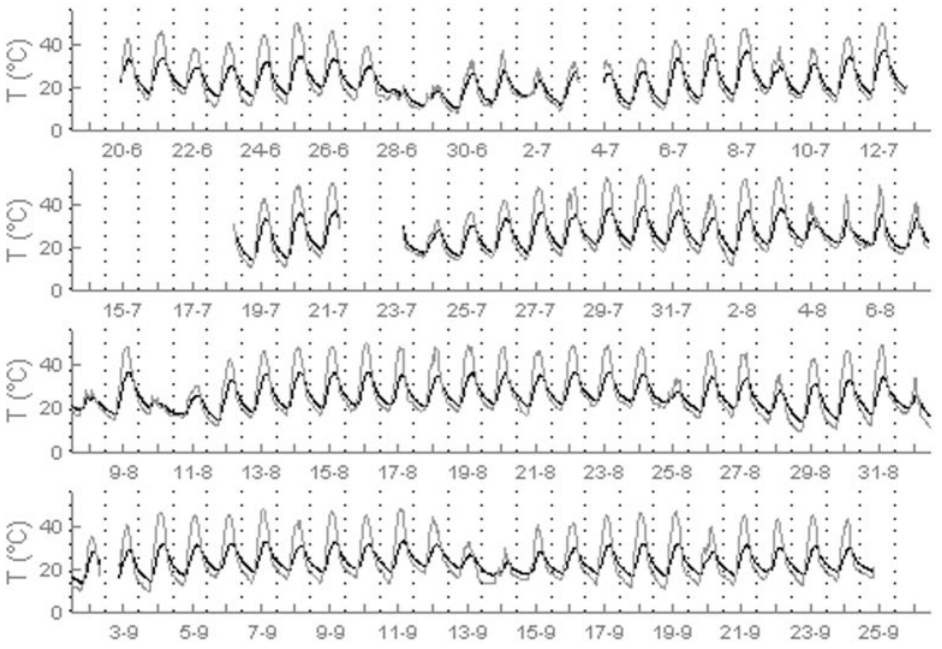
Fig. 10. Soil ( black ) and soil surface ( grey ) temperatures times series for the 1997 WELSONS experiment (see Table 4 for exact locations). Data are from the station installed on the RT plot,